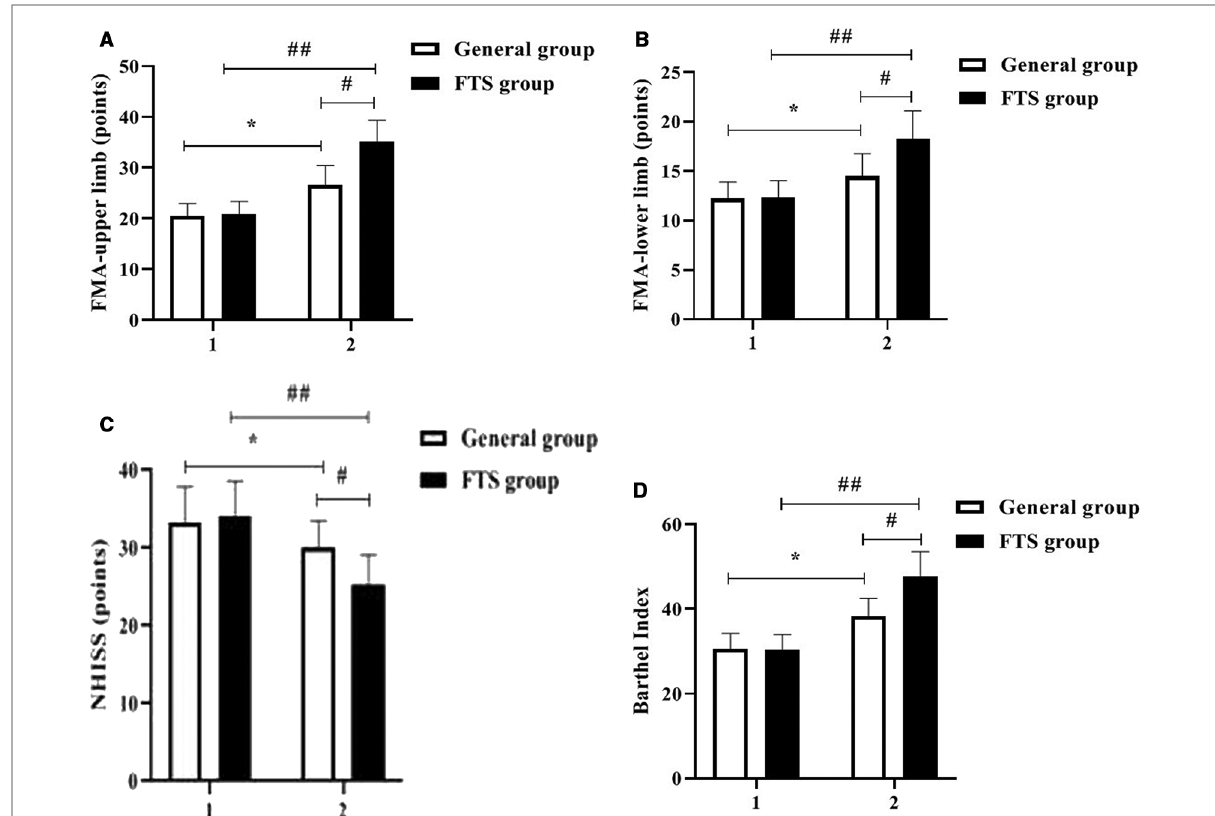
FIGURE 2 Comparison of motor nerve function between the two groups before and after intervention. In the fi gure, 1 represents before intervention and 2 represents after intervention. * Indicates the comparison of the general group before and after intervention, P <0.05; # Indicates the comparison of the FTS group with the general group after intervention, P <0.05; ## Indicates the comparison of the FTS group before and after intervention, P <0.05. Figure ( A-D ) shows the comparison of FMA-upper limb, FMA-lower limb, NIHSS score, and Barthel index between the two groups,